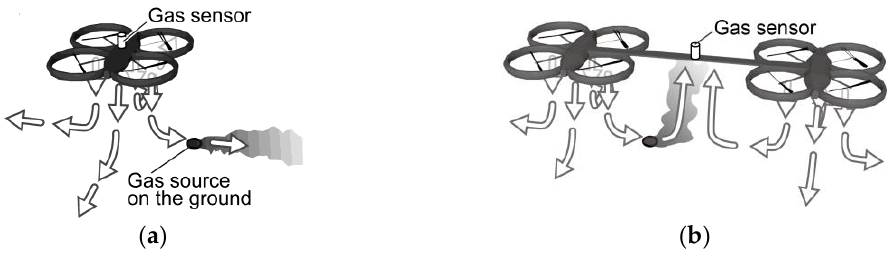
Figure 1. ( a ) Schematic diagram of the air currents generated by a single quadcopter; the gas released from the ground is blown away from the quadcopter. ( b ) Schematic diagram of the air currents generated by two connected quadcopters; the gas released from the ground source is brought to the sensor by the upward fountain flow.